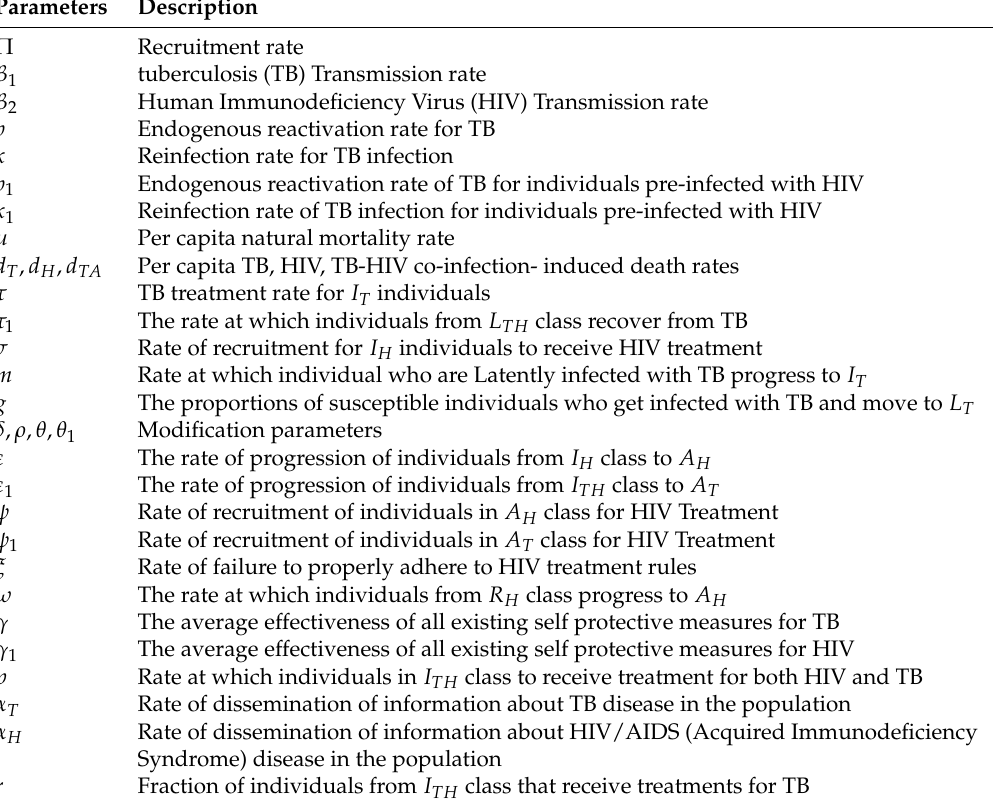
Table 1. Symbols and Description of